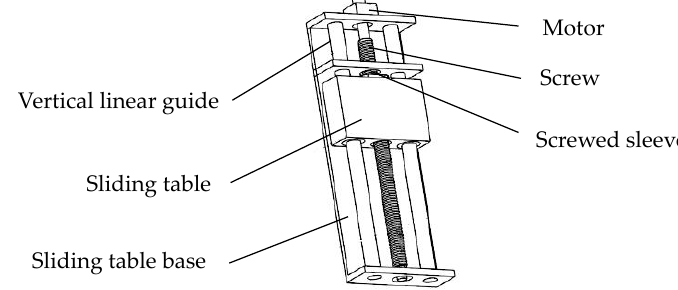
Figure 33. Soil digging and covering mechanism.